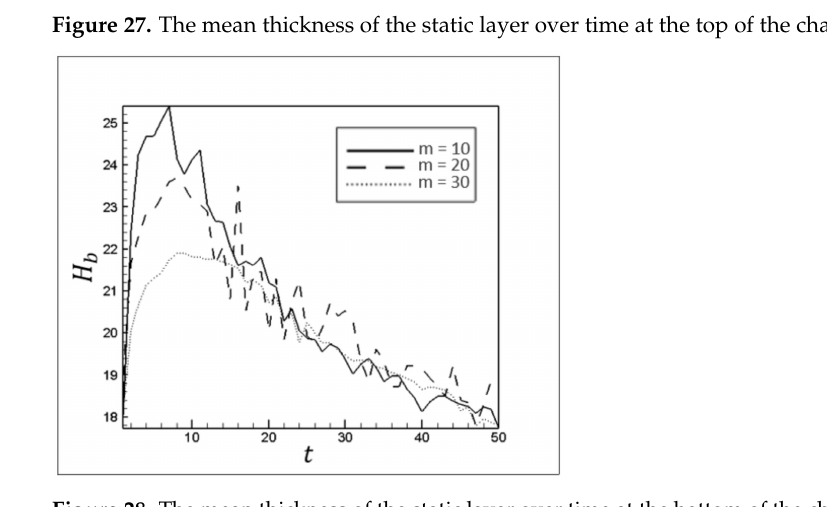
Figure 28. The mean thickness of the static layer over time at the bottom of the channel for different m.